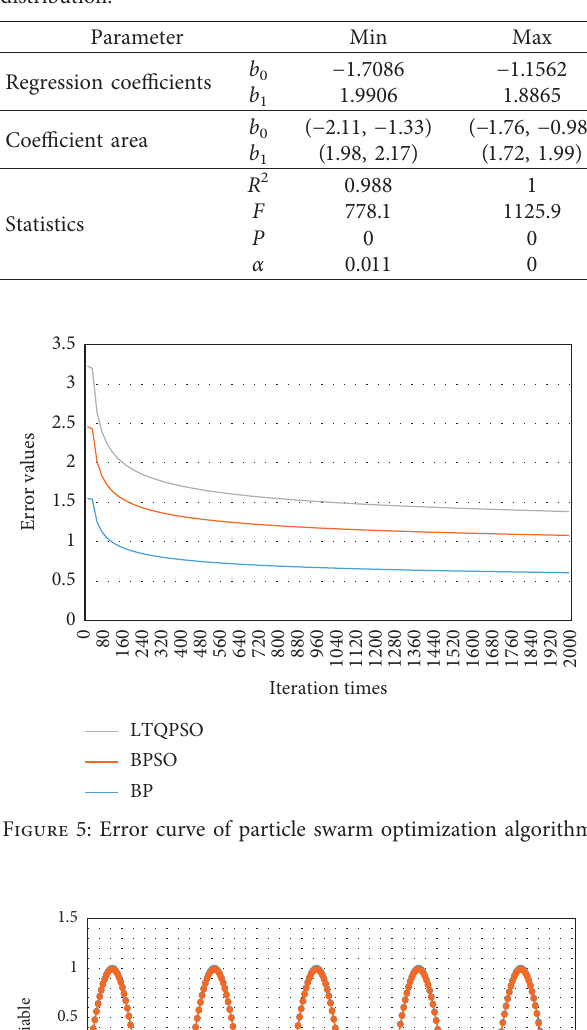
Table 2: Parameter regression analysis results of normal distribution.